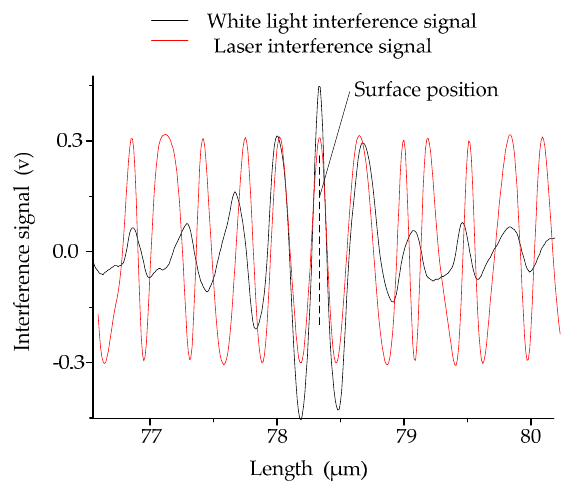
Figure 12. The signal of the combination of laser interference and white light interference.